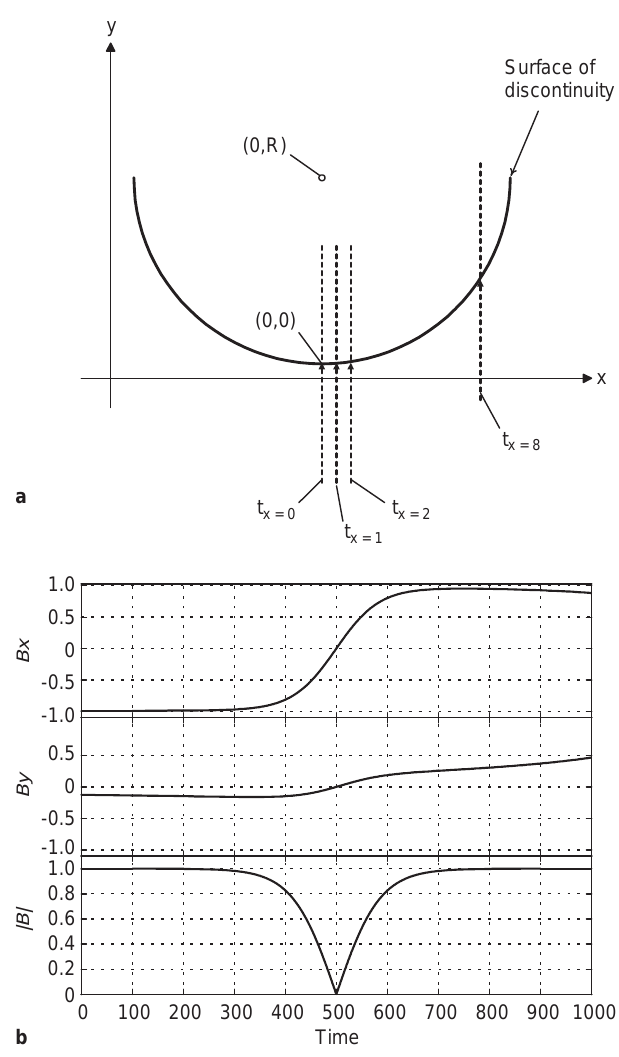
Fig. 4a, b. Schematic drawing of sampling trajectories through a circular discontinuity model and the associated data (time and magnetic field values in arbitrary units). The magnetic field model is defined as follows: